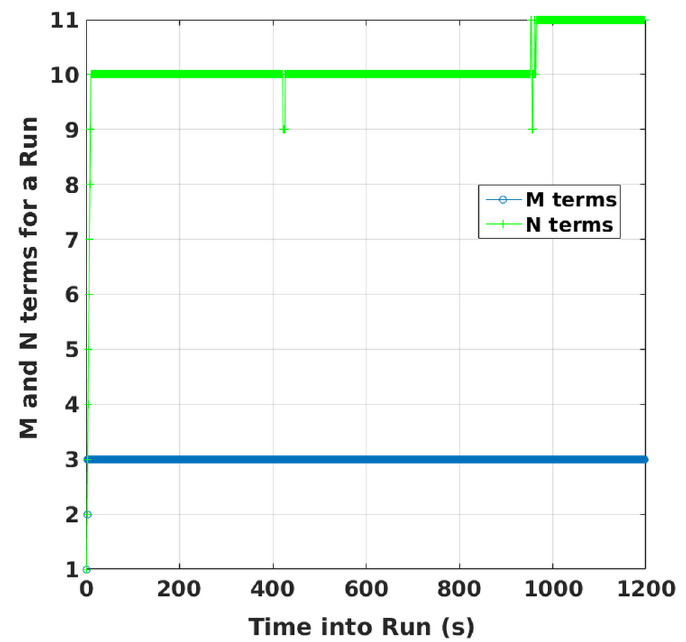
Figure 7. Numbers of M and N terms of range-based KF RAIM for a simulation.